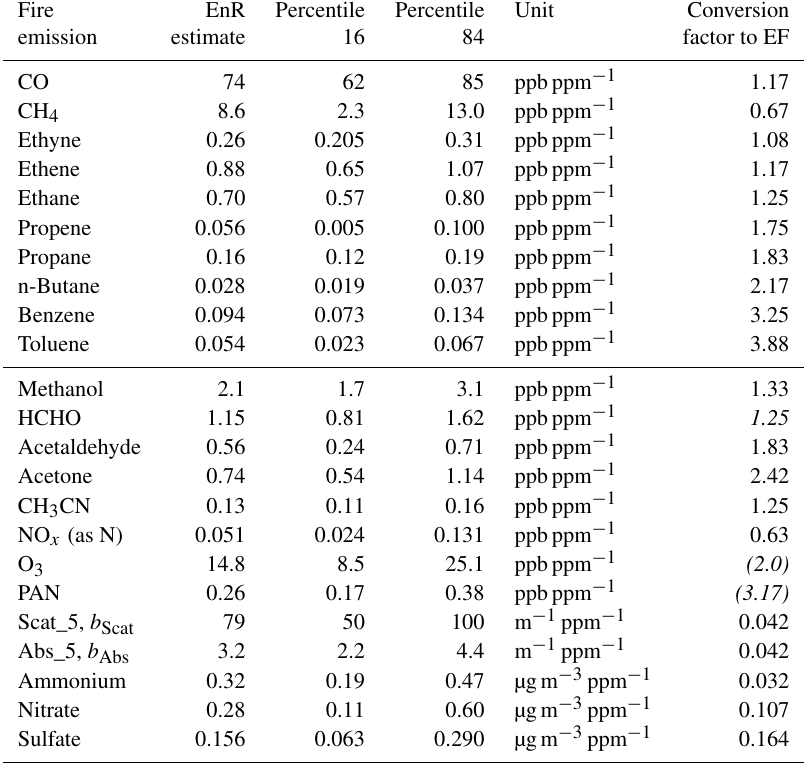
Table 3. EnR estimates for fire emissions